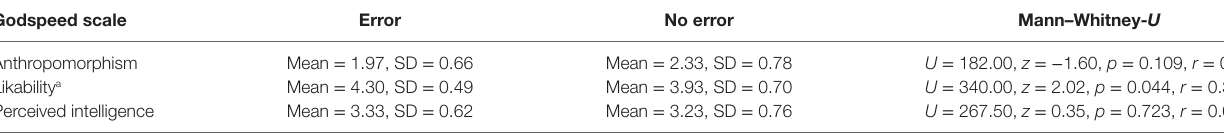
Table 4 | nars s1 mean values (sD) before and after interaction for male and female participants. nars s1 Males Females Before Mean = 1.77, SD = 0.54 Mean = 2.46, SD = 0.42 After Mean = 1.87, SD =